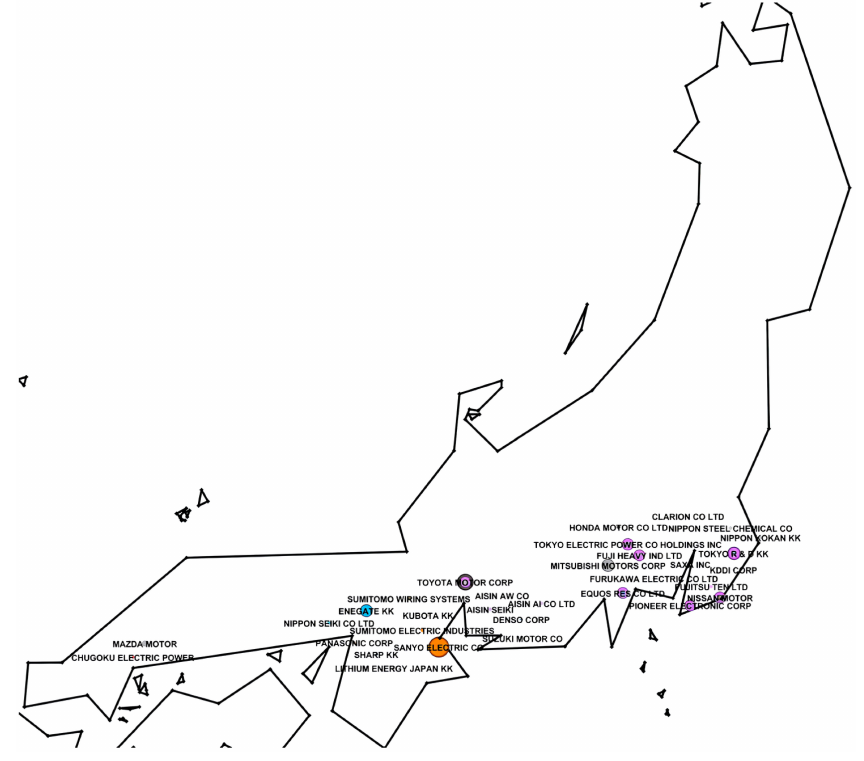
Figure 4. Visualization of geographically mapped patent-holding